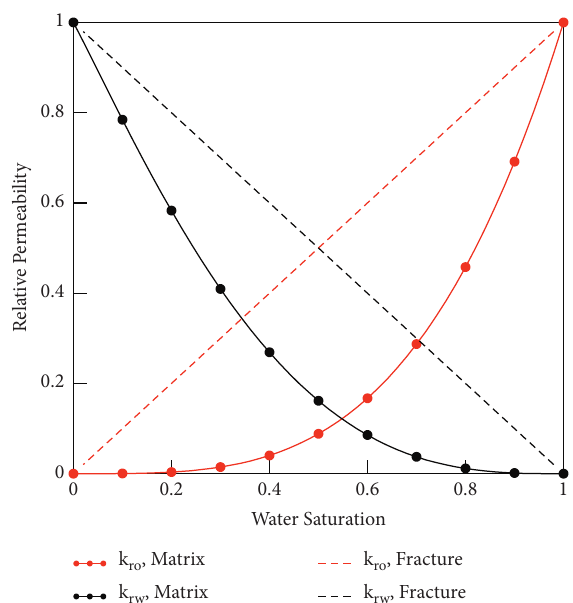
Figure 21: Relative permeability curves of the rock matrix and